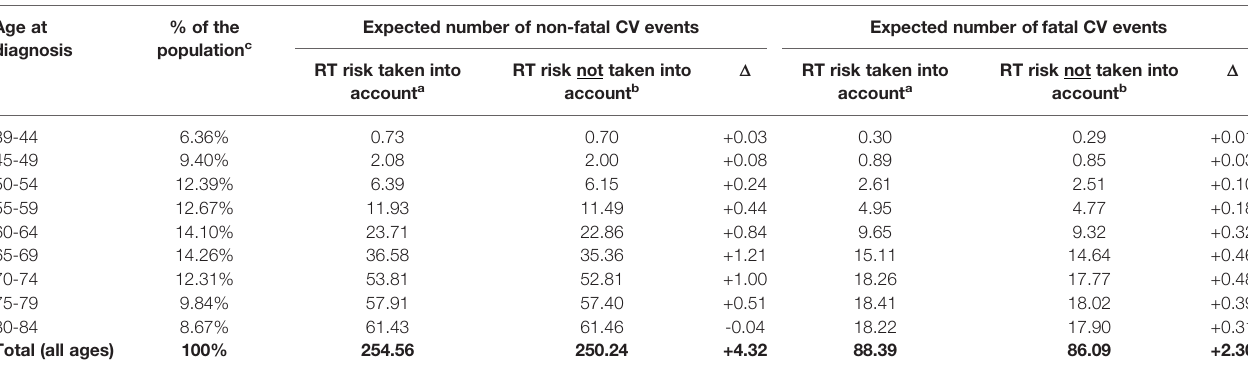
TABLE 2 | Baseline results in a total cohort of 1,000 female breast cancer survivors 1 . Age at